Question: Condense the content of this figure into a single sentence.
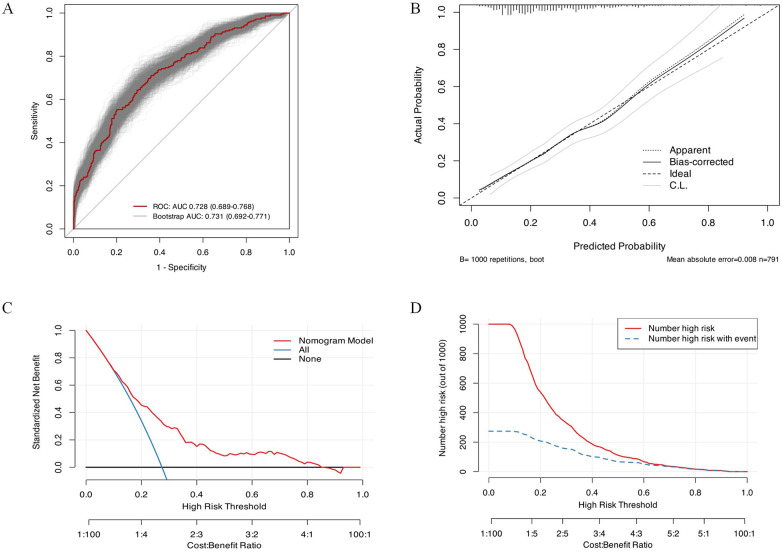
Answer: Performance evaluation of the nomogram prediction model. (A) ROC curve showing an AUC of 0.728 (95% CI: 0.689–0.768); (B) Calibration curve of the nomogram after 1,000 bootstrap resamples, demonstrating good agreement between the predicted and observed probabilities of prolonged fever (mean absolute error = 0.008); (C) DCA indicating positive net benefit across threshold probabilities of 9%–85%. (D) CIC showing effective identification of high-risk cases within the 20%–30% threshold range. ROC, receiver operating characteristic; AUC, area under the receiver operating characteristic curve; CI, confidence interval; DCA, decision curve analysis; CIC, clinical impact curve.